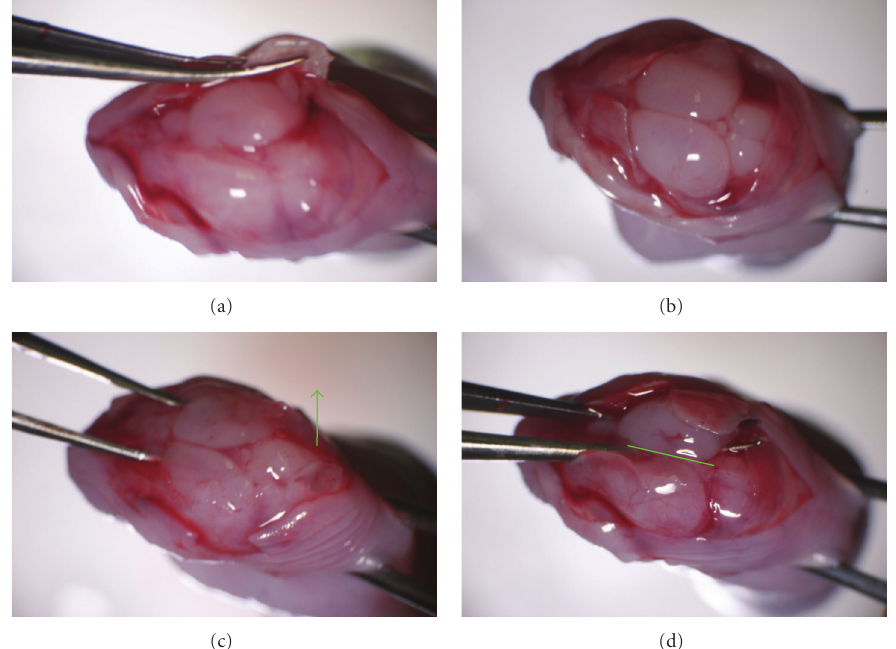
Figure 3: (a) Removal of the skull, (b) removal of the cerebral dura mater, (c) traditional approach, and (d) removal of the cortex.